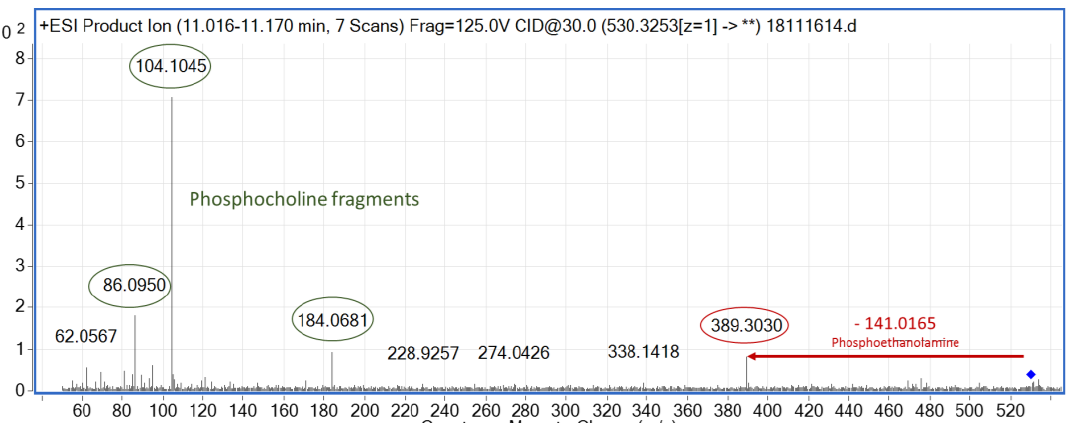
Figure 6. Experimental MS/MS spectrum for the significant feature in positive ionization mode with m/z 530.3253 and RT 11.04 min.